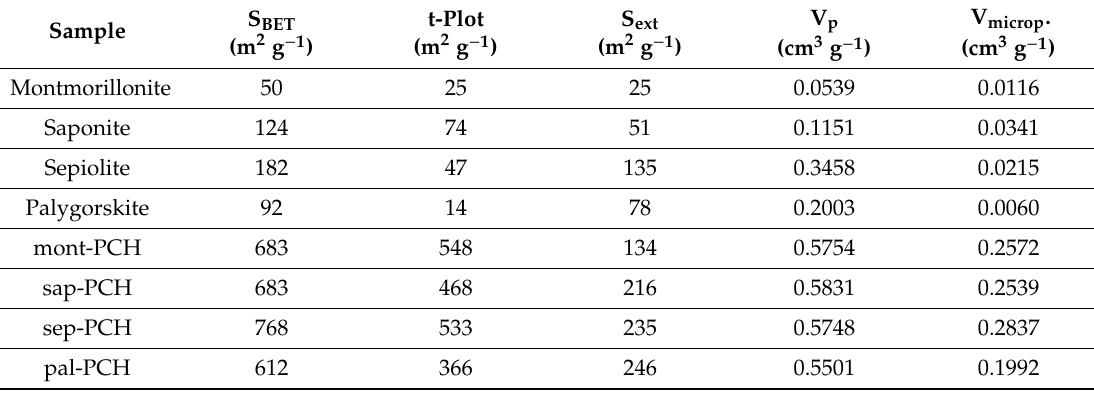
Figure 7. N 2 adsorption–desorption isotherms at − 196 °C of the montmorillonite, saponite, sepiolite and palygorskite ( A ) and their respective PCHs ( B ). Table 1. Textural properties of the raw clays and their respective